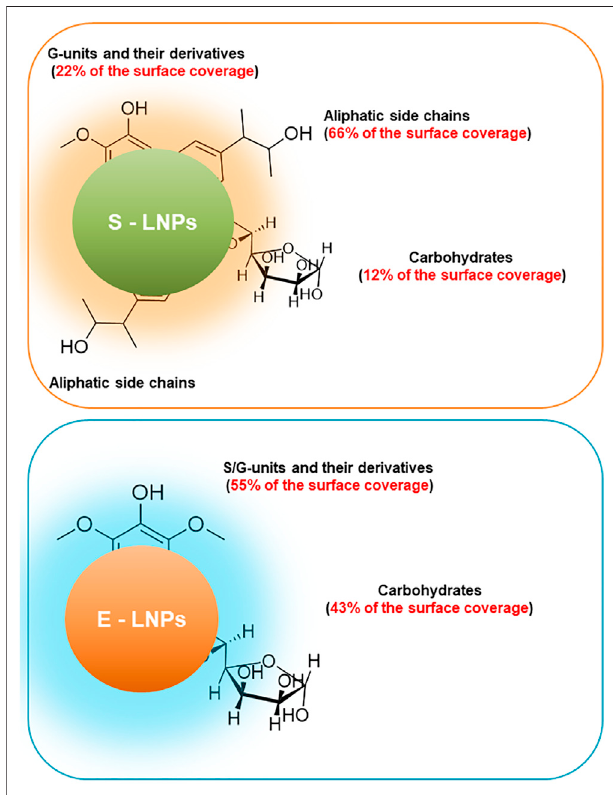
FIGURE 5 | Surface of E-LNPs is covered mostly by S/G-units and carbohydrates, whereas surface of S-LNPs has three times lower carbohydrate content and G-units but is rich in aliphatic side chains. SchematicrepresentationofthesurfacecompositionofLNPsfromhigh- M w ligninfractions.Theratiobetweenaliphatic-andG-unitswasshownhigher for S-LNPs, while the surface of E-LNPs contained an almost 1:1 ratio between carbohydrates and S/G aromatic units and was almost free of aliphatic side units of lignin.